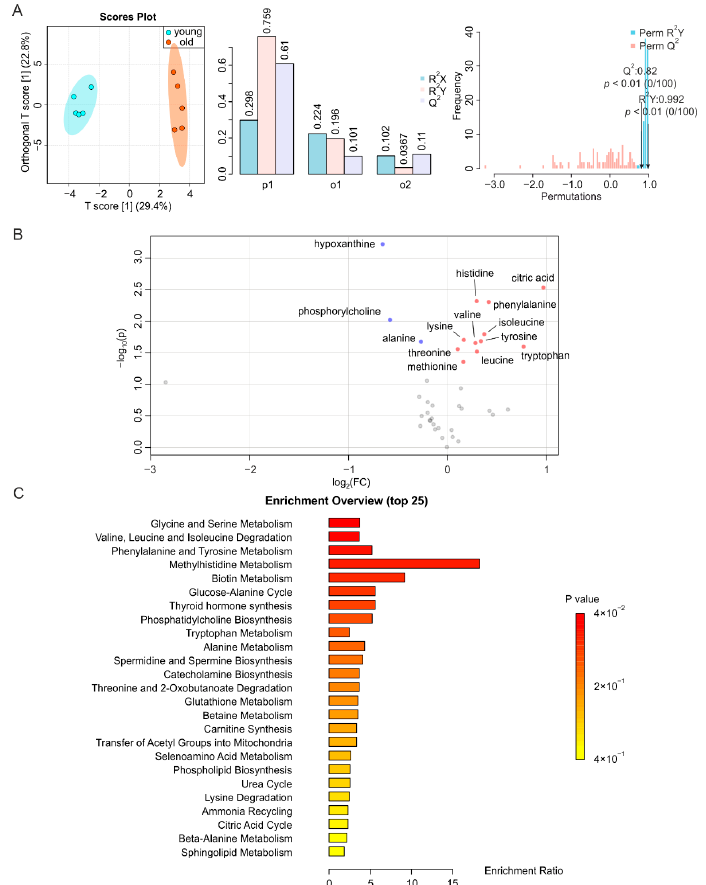
Figure 3. NMR-based metabolomics analysis of BAT. ( A ) O-PLS-DA plot and cross validation of BAT samples from young (blue) and old (orange) mice (left), with n = 5 each, and permutation be- tween predictive component (p1) and two orthogonal components (o1, o2) with cross-validated R 2 X, R 2 Y and Q 2 coefficients (middle), and histogram showing the permutation test with permutation number n = 100 (right). ( B ) Volcano plot of differentially regulated metabolites in BAT from young and aged mice. Increased (red) and decreased (blue) metabolites delimitate the fold change over aging, while grey dots denote insignificantly changed metabolites. ( C ) MSEA of affected metabo- lites, in search of their functional relevance.